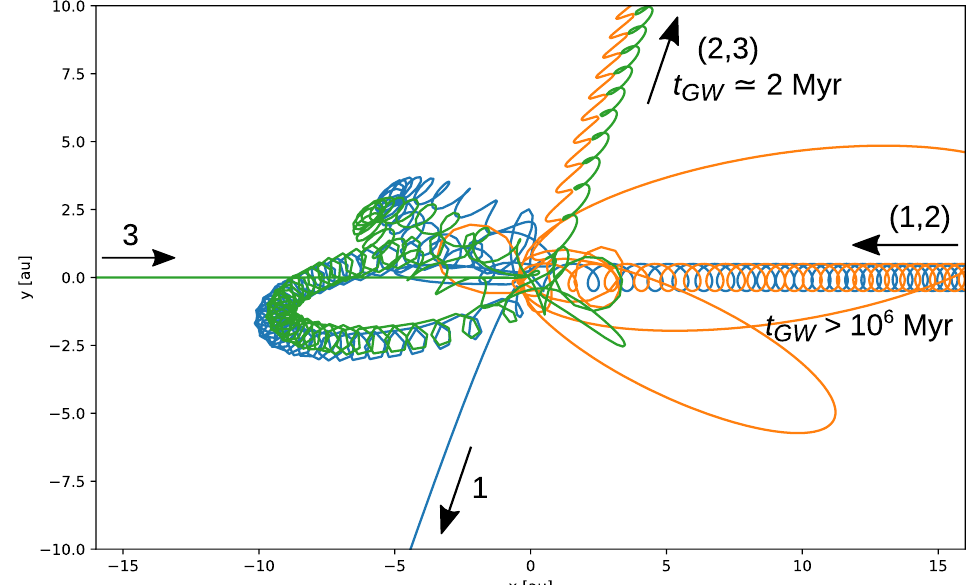
Figure 8. Trajectories during a three-body encounter between a binary (1,2) and a single (3). After a brief chaotic interaction, the binary and the single undergo an exchange. The encounter is concluded by the ejection of the new binary (2,3) and the new single (1). The initial coalescence time of the binary is t GW > 10 6 Myr, much greater than a Hubble time. After the interaction, the coalescence time is t GW (cid:39) 2Myr. The initial approach of the binary-single is hyperbolic, with an impact parameter of b = 0.6 au and velocity at infinity of v ∞ = 0.1km/s. All the bodies are 50M (cid:12) BHs integrated with TSUNAMI (Trani et al., in prep.), including post-Newtonian corrections of order 1PN, 2PN and 2.5PN to the equations of